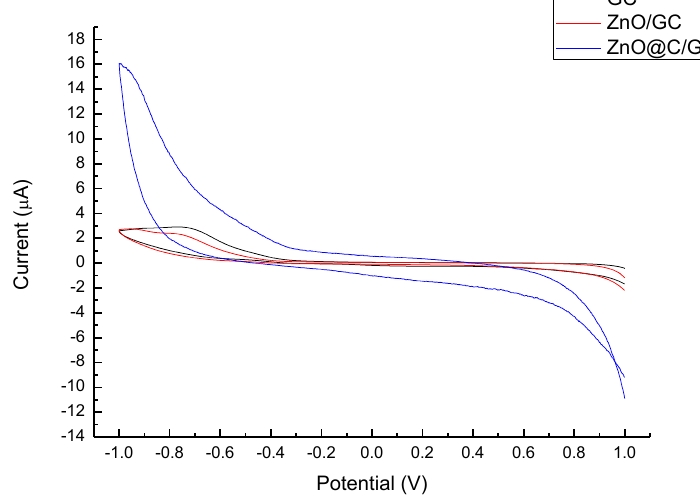
Figure 6. Cyclic voltammetric (CV) profiles of GC, ZnO/GC, and ZnO@C/GC electrodes in 1 M NaOH (aq) solution.